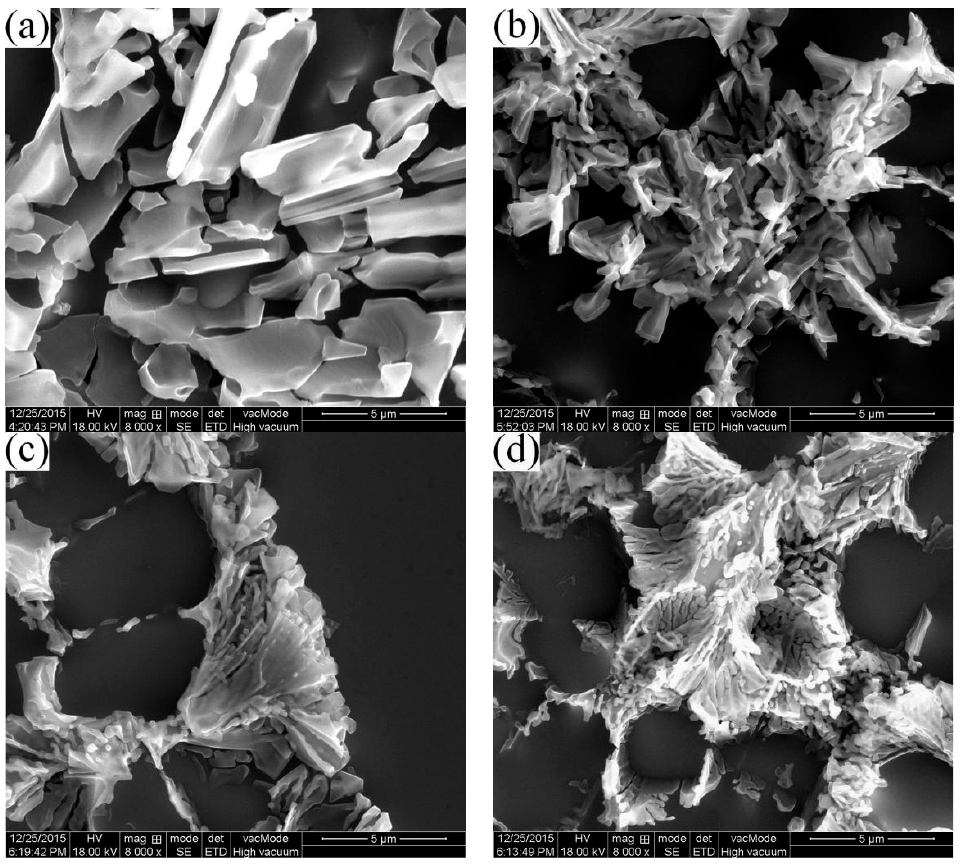
Figure 9. Morphology of the eutectic structures in different positions of die casting ( a ) biscuit, A; ( b ) in-gate, B; ( c ) down, C; ( d ) middle, D.